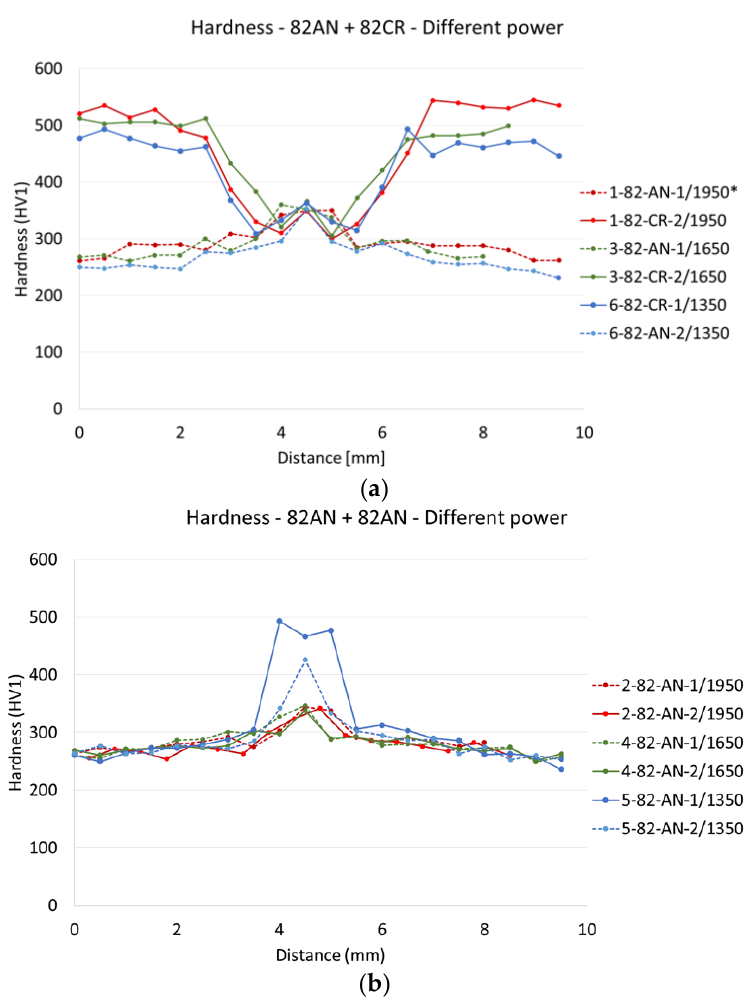
Figure 9. Hardness of weld joints made with various laser power levels: ( a ) T15-82a + T15-82c; ( b ) T15-82a + T15-82a (*1-82-AN-1/1950 means: Sample ID 1 , sheet T15- 82 , annealed, 1 —upper sheet, power 1950 W).